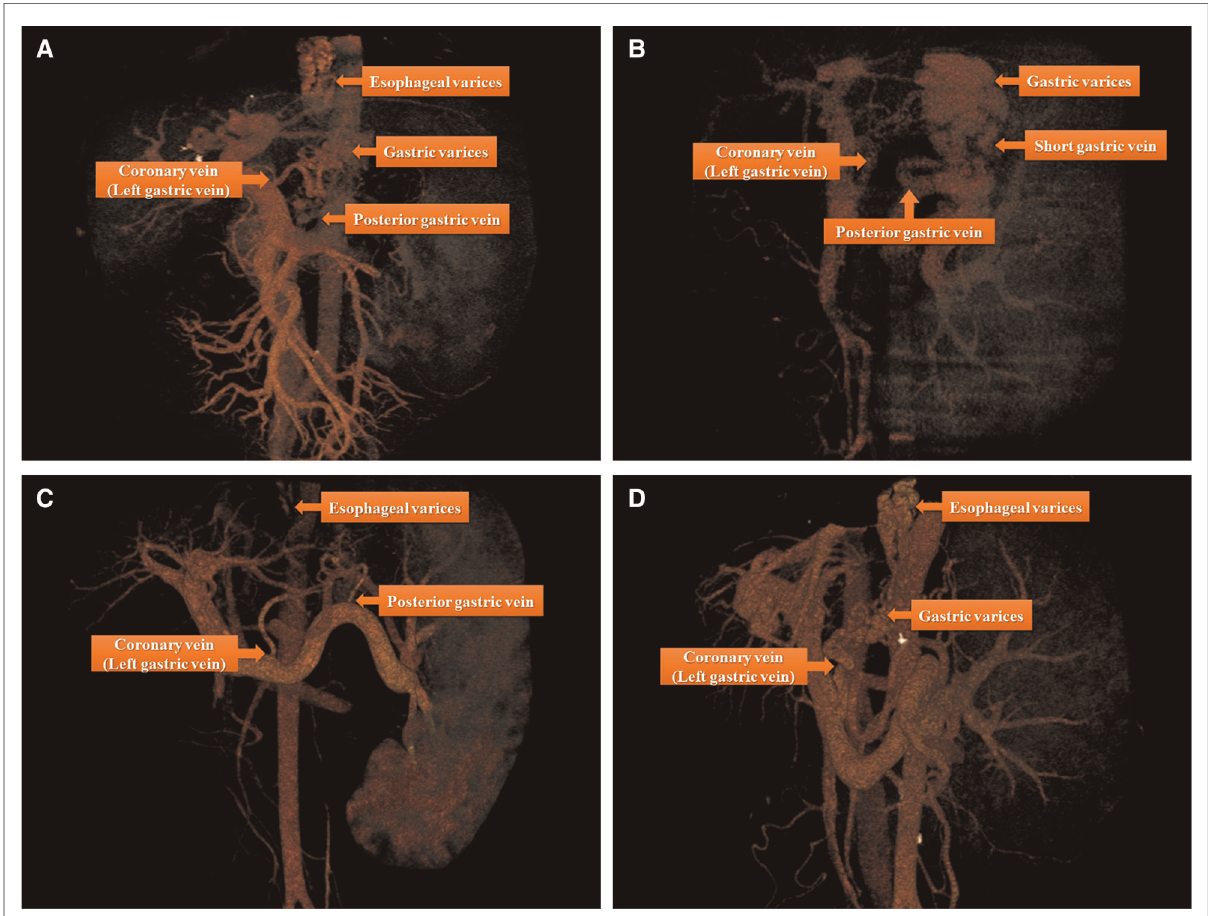
FIGURE 1 There are four major types of anatomical variations of portal vein system by three-dimensional images reconstruction based on the data derived from 64-slice spiral CT: ( A ) Esophageal and gastric varices (the source of bleeding) were found to fl ow into coronary vein (left gastric vein) and posterior gastric vein; ( B ) gastric varices (the source of bleeding) were found to fl ow into posterior gastric vein and short gastric vein; ( C ) Esophageal varices (the source of bleeding) were found to fl ow into coronary vein (left gastric vein) and posterior gastric vein; ( D ) Esophageal and gastric varices (the source of bleeding) were found to fl ow into coronary vein (left gastric